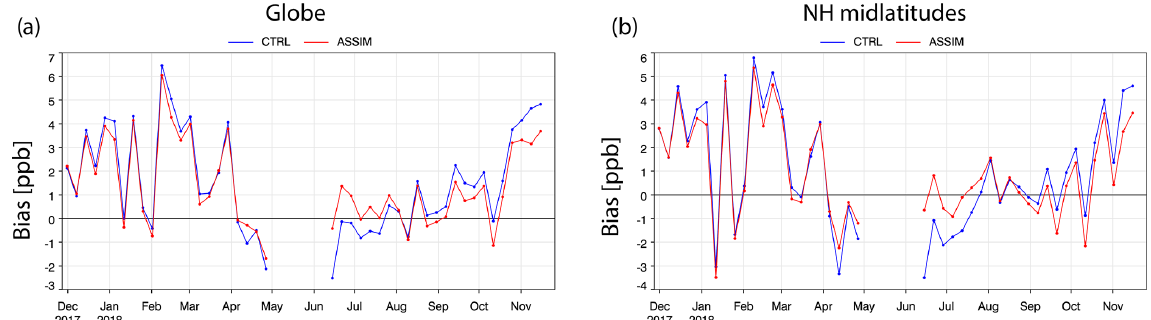
Figure 11. Time series of weekly averaged TCO3 bias in DU from ASSIM (red) and CTRL (blue) compared to WOUDC Brewer data averaged over (a) the globe (between 15 and 33 sites) and (b) NH midlatitudes (between 12 and 19